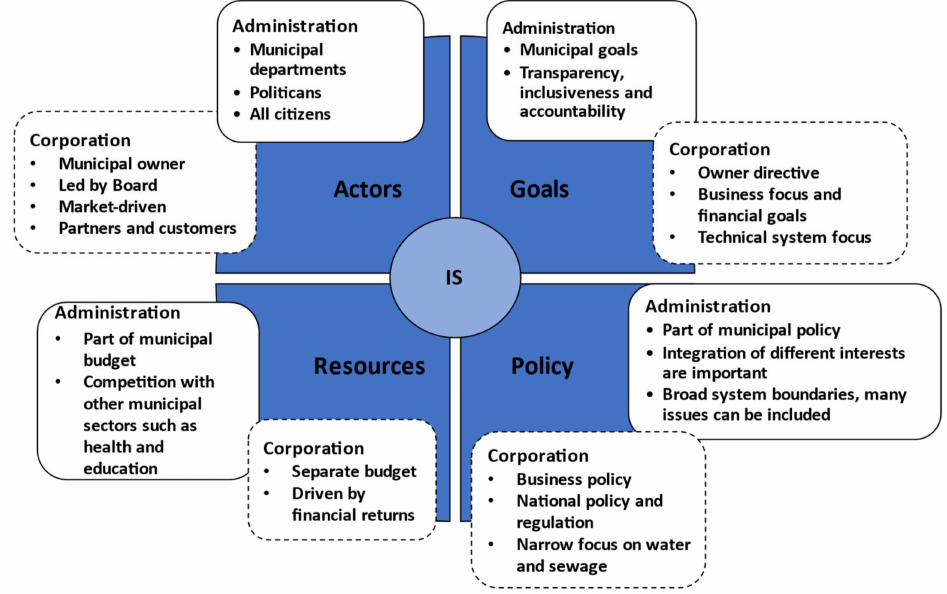
Figure 2. Analytical framework showcasing the impact of public organization forms on actors, goals, resources, and policy in industrial